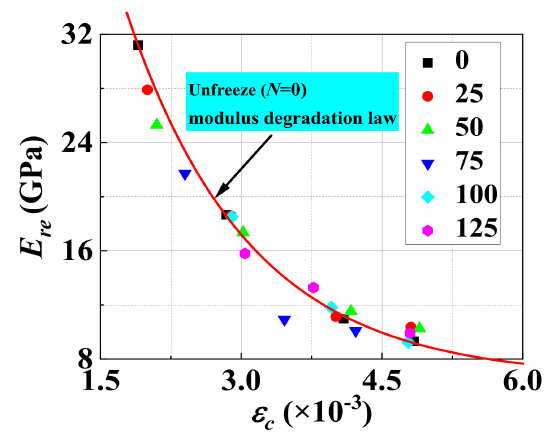
Figure 8. Relationship between reloading modulus and strain after peak point